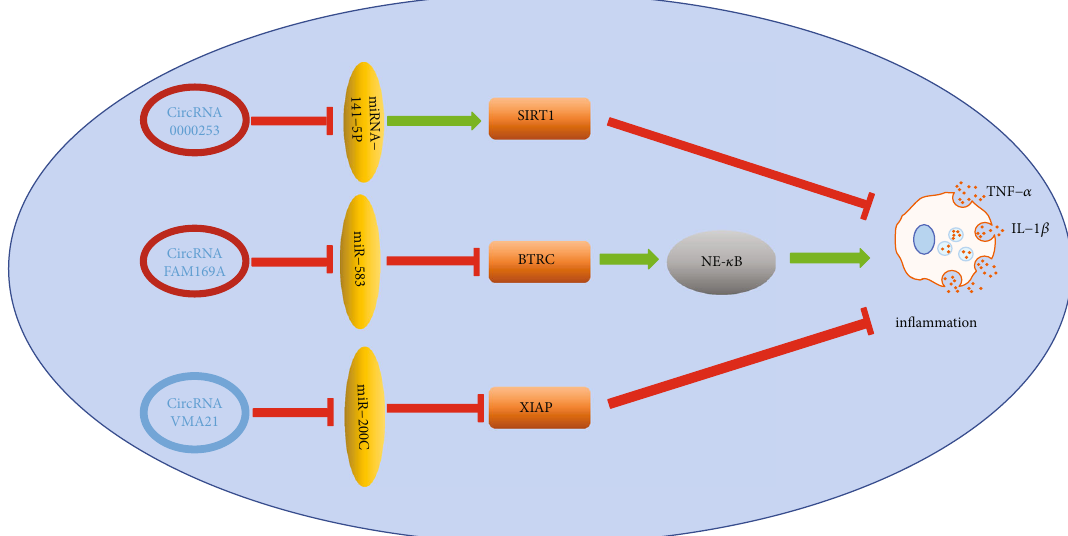
Figure 2: Among the reported circRNA, three kinds of circRNA play an important role in intervertebral disc in fl ammation, among which circRNA0000253 and circRNA FAM169A can promote the synthesis and secretion of intervertebral disc in fl ammatory cytokines, promoting the occurrence of in fl ammatory reaction and promoting intervertebral disc degeneration. On the other hand, circRNA VMA21 can inhibit the in fl ammatory reaction of intervertebral disc and protect the intervertebral disc to a certain